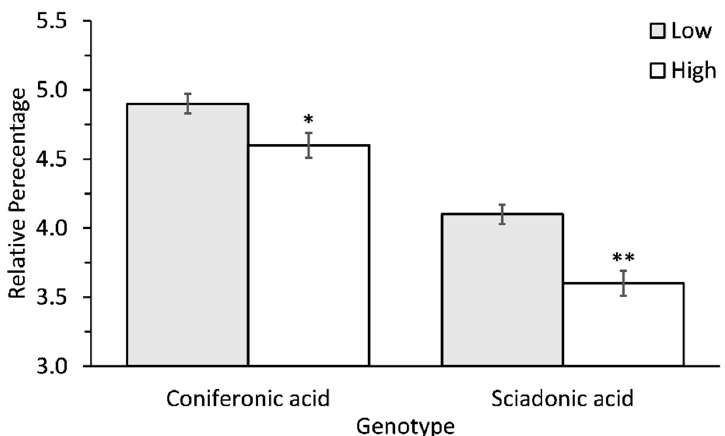
Figure 4. Fatty acids in balsam fir branches that only had significant differences between low and high needle abscission resistance regardless of sampling time. Each mean was calculated using 50 branches. Error bars represent standard error. An * indicates 1 to 5% significance while ** indicates less than 1% significance when high NAR genotypes are compared to low NAR genotypes.